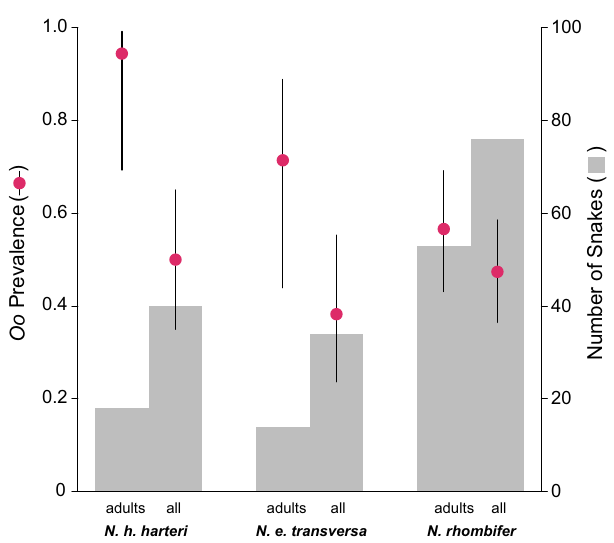
Figure 2. Number of wild-caught adults and total sample size (all) for three Nerodia species tested for the presence of Ophidiomyces ophiodiicola via qPCR indicated by gray bars. Closed circles represent estimates of prevalence for each species and a subset of adults, with black lines showing the 95% confidence